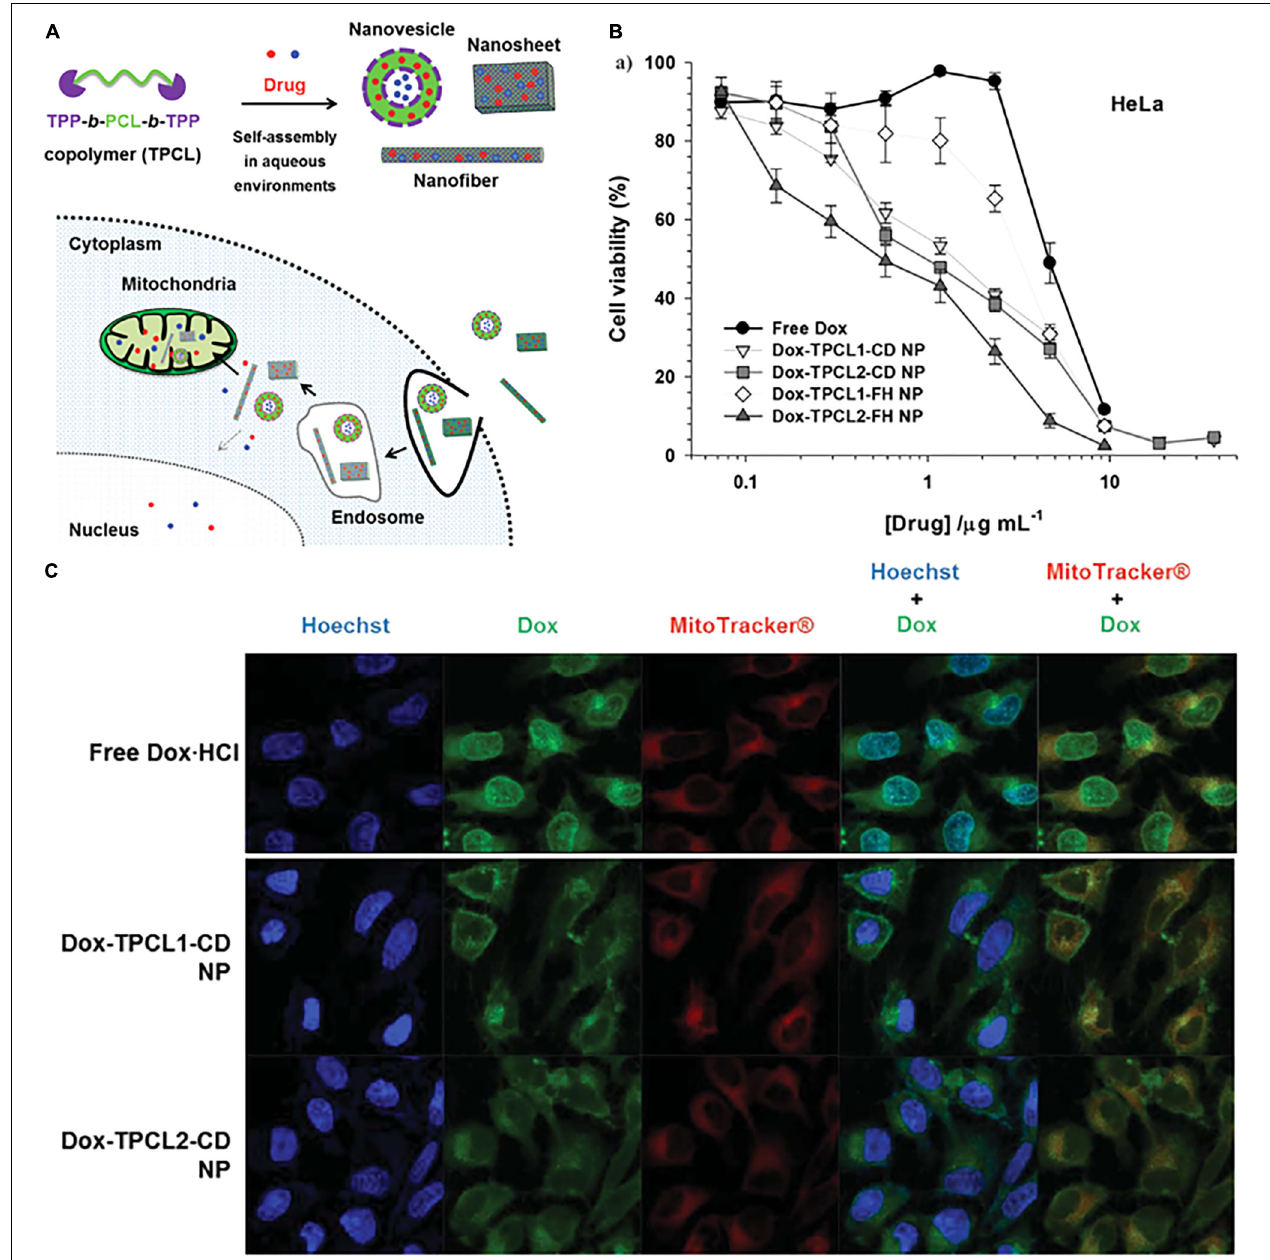
FIGURE 5 | (A) Illustrated design concept of drug-loaded TPCL nanoparticles (NPs) in cells. The red solid circle ( • ) and blue solid circle ( • ) indicate hydrophobic and hydrophilic chemical drugs, respectively. (B) In vitro antitumor effects of Dox-loaded TPCL NPs in HeLa cells. (C) Intracellular distribution of free drugs and drug-loaded TPCL NPs and Dox-TPCL-CD NPs with [Dox] = 1 µ g mL − 1 in HeLa cells at 4 h post-treatment. Images were adapted with permission from reference (Cho et al.,